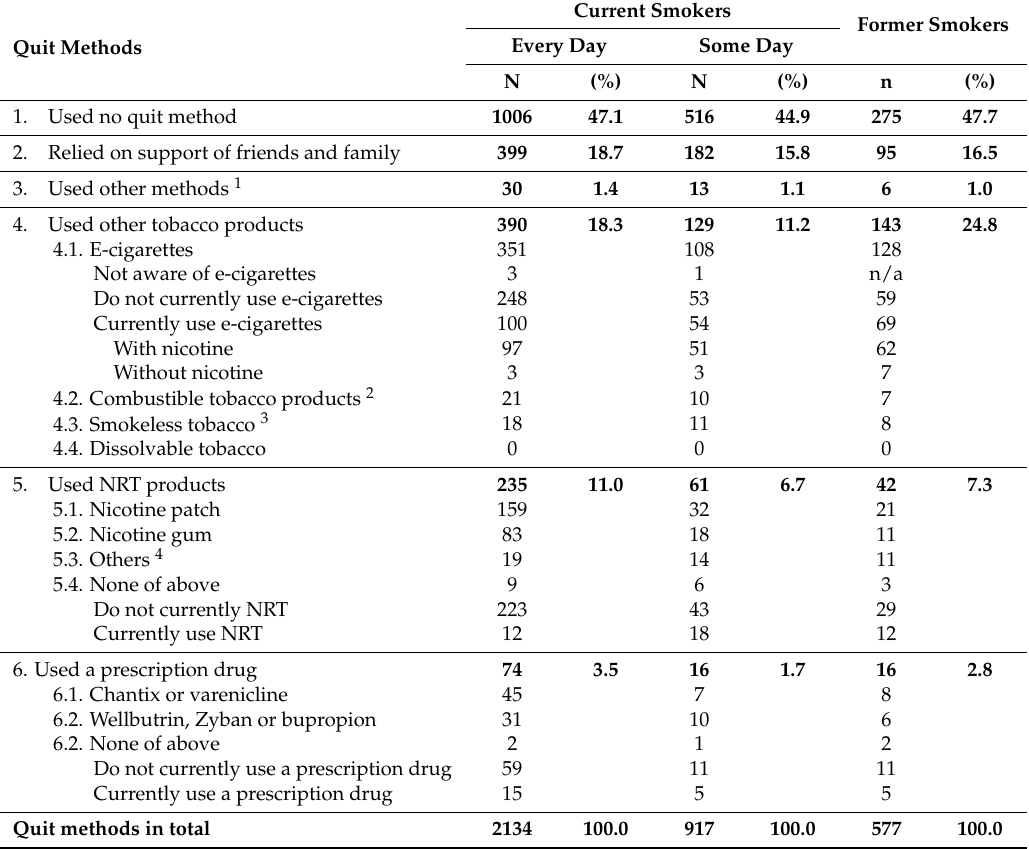
Table 2. Numbers and percentages of current and former smokers using a single or no quit method in the past 12 months.